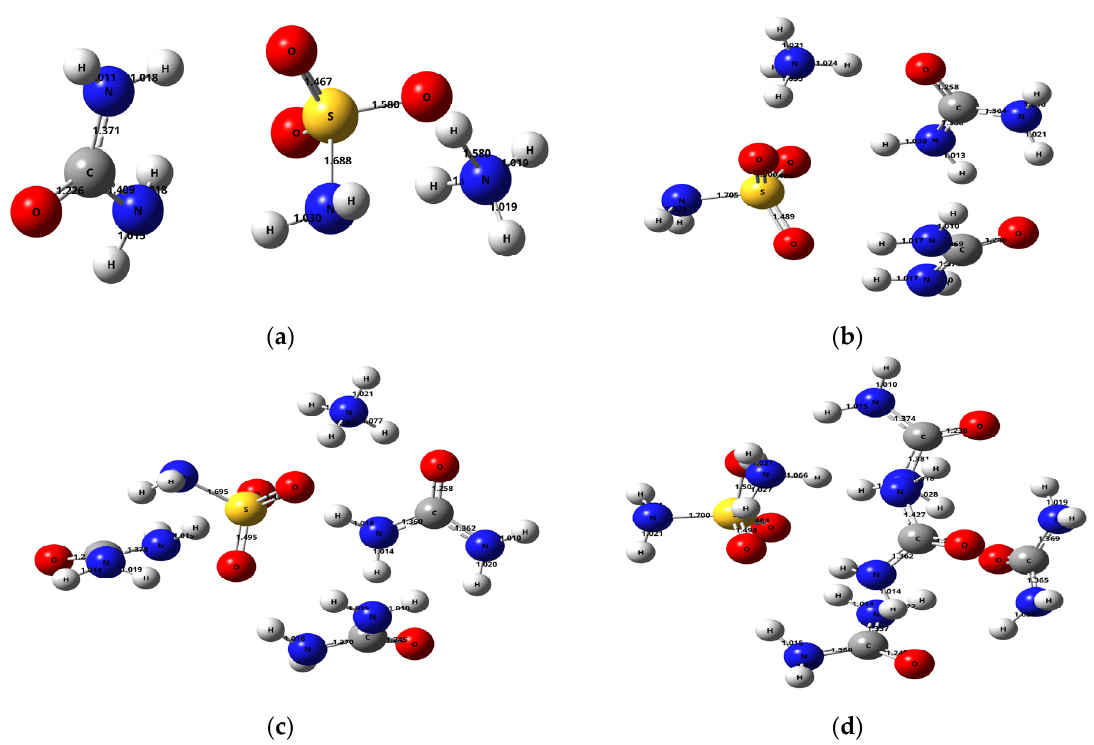
Figure 5. Optimized structures of the ammonium sulfamate system with ( a ) one, ( b ) two, ( c ) three, and ( d ) four urea molecules.